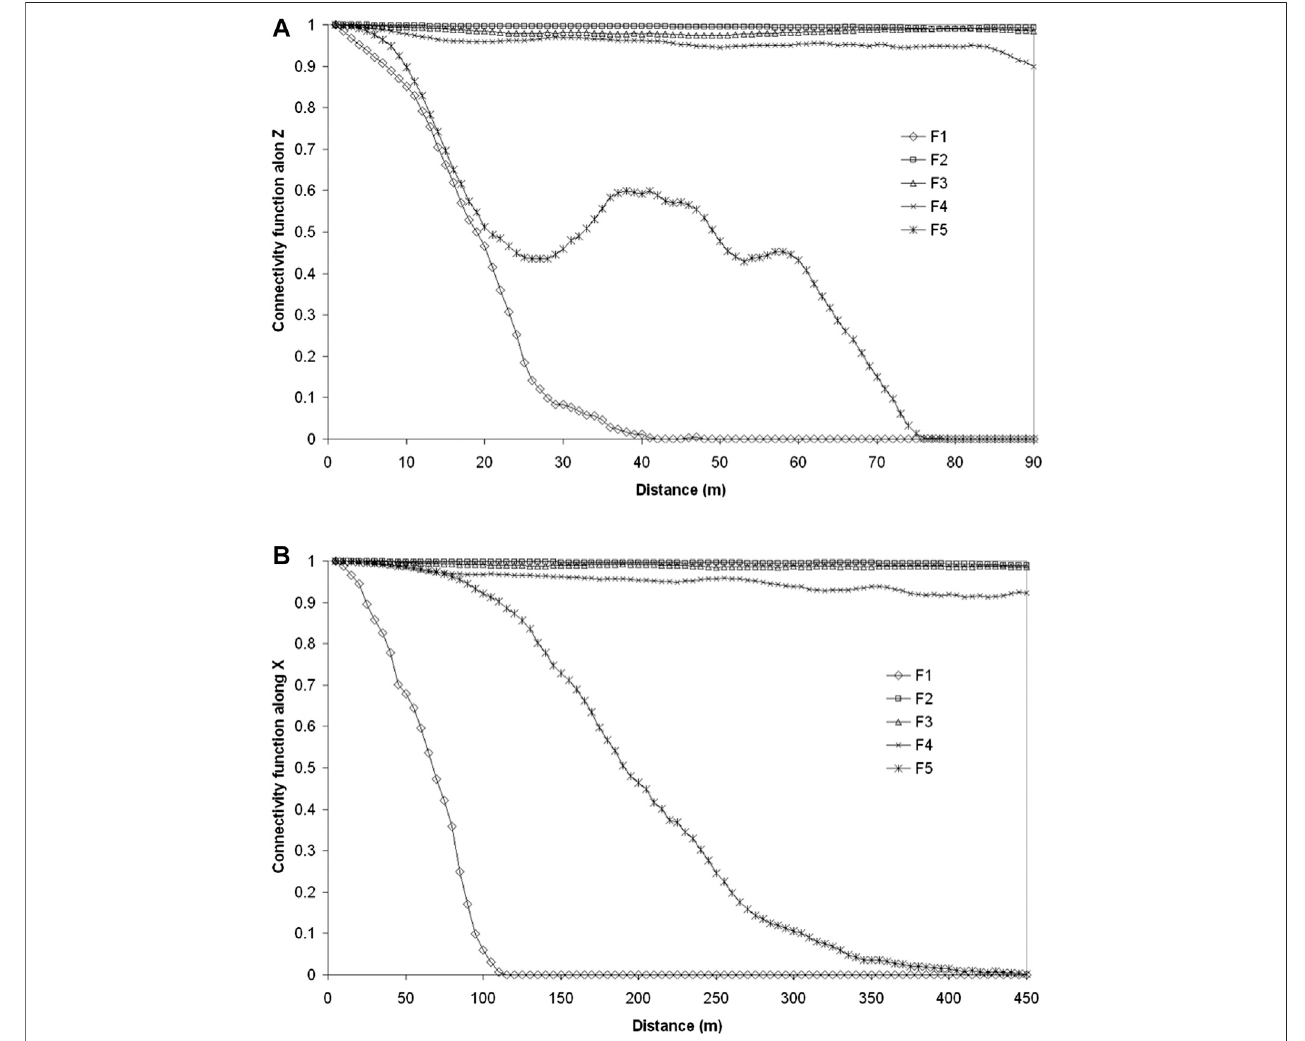
FIGURE 13 | Connectivity function for the different hydrofacies. (A) Vertical direction. (B) X direction.